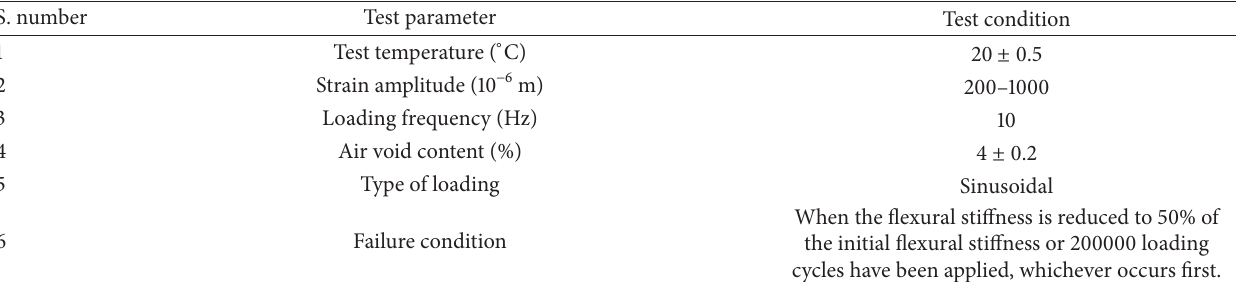
Table 3: Test condition adopted for 4PBB